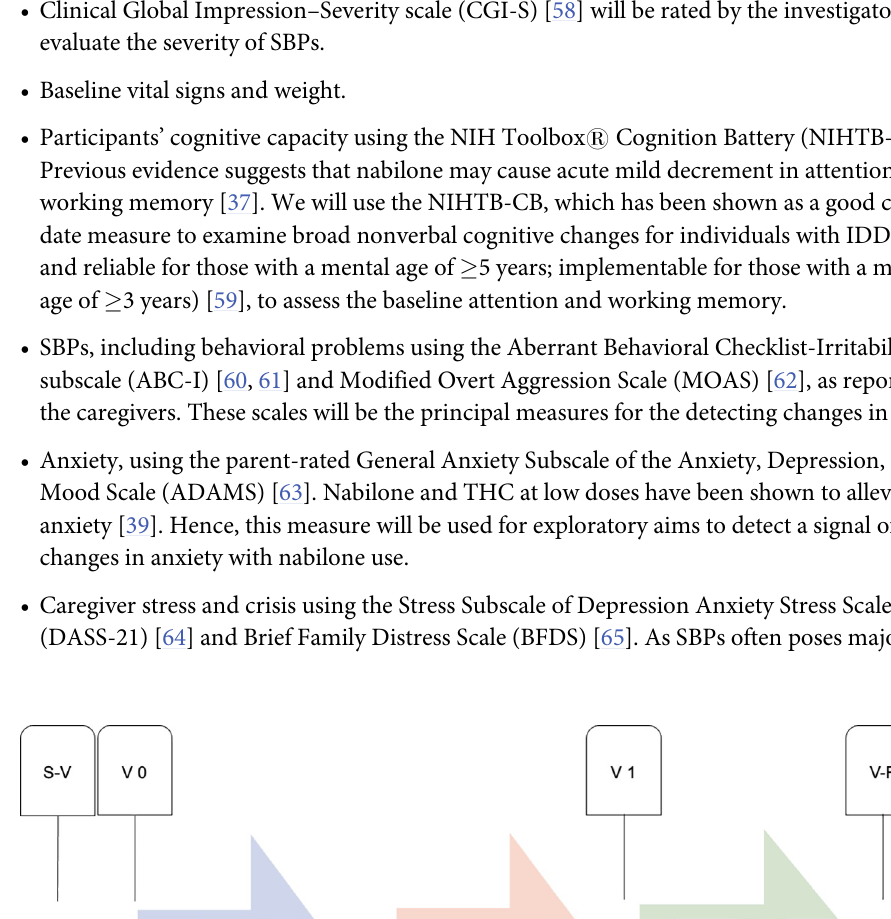
Fig 1. Schedule of study visit procedures and assessments. Abbreviation: Dx = diagnosis; MacCAT-CR = MacArthur Competence Assessment Tool for Clinical Research; Moss-PAS (ID) = Moss Psychiatric Assessment Schedules; ABAS-3 = Adaptive Behavior Assessment System, Third Edition; PE = physical examination; AE = adverse event and severe adverse event; NIH-Toolbox = NIH Toolbox 1 Cognition Battery; ABC-I = Aberrant Behavior Checklist-Irritability Subscale; MOAS = Modified Overt Aggression Scale; CGI-I = Clinical Global Impressions (CGI) scale-Improvement; CGI-S = Clinical Global Impressions (CGI) scale-Severity; Anxiety-ADAMS = General Anxiety Subscale of Anxiety, Depression, and Mood Scale; Stress-DASS-21 = Stress Subscale of the short-form version of Depression Anxiety Stress Scales; BFDS = Brief Family Distress Scale; SCQ-AIQ = Social Communication Questionnaire for Adults with Intellectual Disability. a : Either in-person or virtual visit.